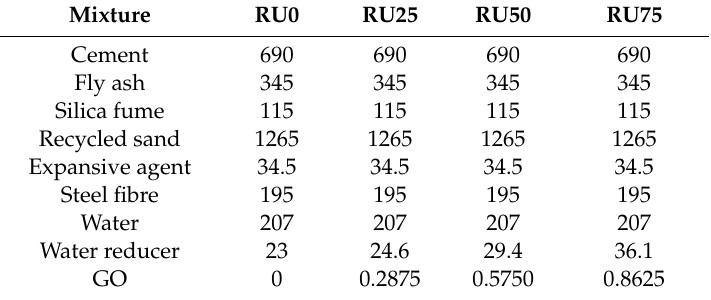
Table 4. The mix proportions of recycled-sand-based ultra-high-performance concrete (RS-UHPC) (kg / m 3 ). Mixture